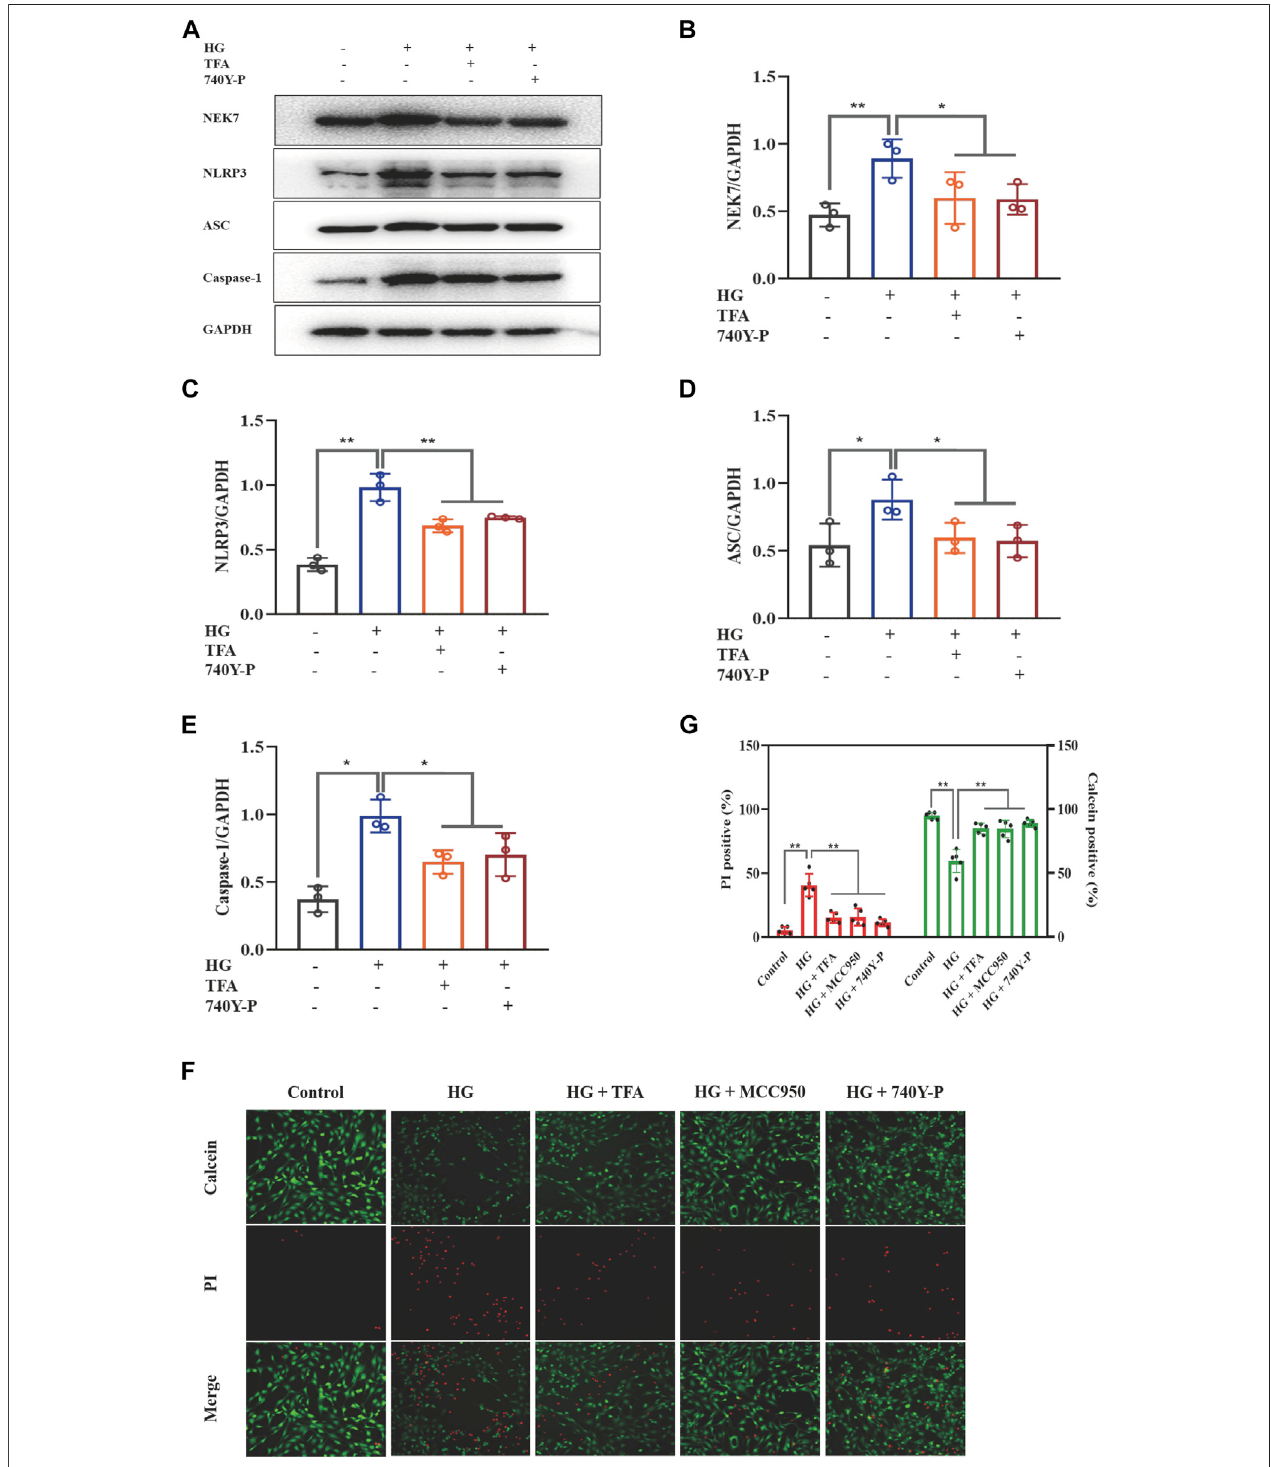
FIGURE 5 | TFA and 740Y-P inhibited HG-induced in fl ammasome activation in MPC-5 cells. (A) WB analysis of NEK7, NLRP3, ASC, and caspase-1, in cultured MPC-5 cells exposed to HG at 30 mM for 48 h with or without TFA (20 μ g/ml) and 740Y-P (30 μ M) treatment for 24 h; (B) NEK7 was quanti fi ed by densitometry; (C) NLRP3 wasquanti fi edbydensitometry; (D) ASC wasquanti fi edbydensitometry; (E) Caspase-1 wasquanti fi edbydensitometry; (F) Representativepictures ofcalcein- AM/PIdoublestains.ThelivecellsarestainedbycalceinandthedeathcellsarestainedbyPI.Four fi elds(200 × )wererandomlyselectedtocalculatethepercentage of alive/dead cells. In this part of the experiment, MPC-5 cells exposed to HG at 30 mM for 48 h with or without TFA (20 μ g/ml), MCC950 (10 μ M) and 740Y-P (30 μ M)